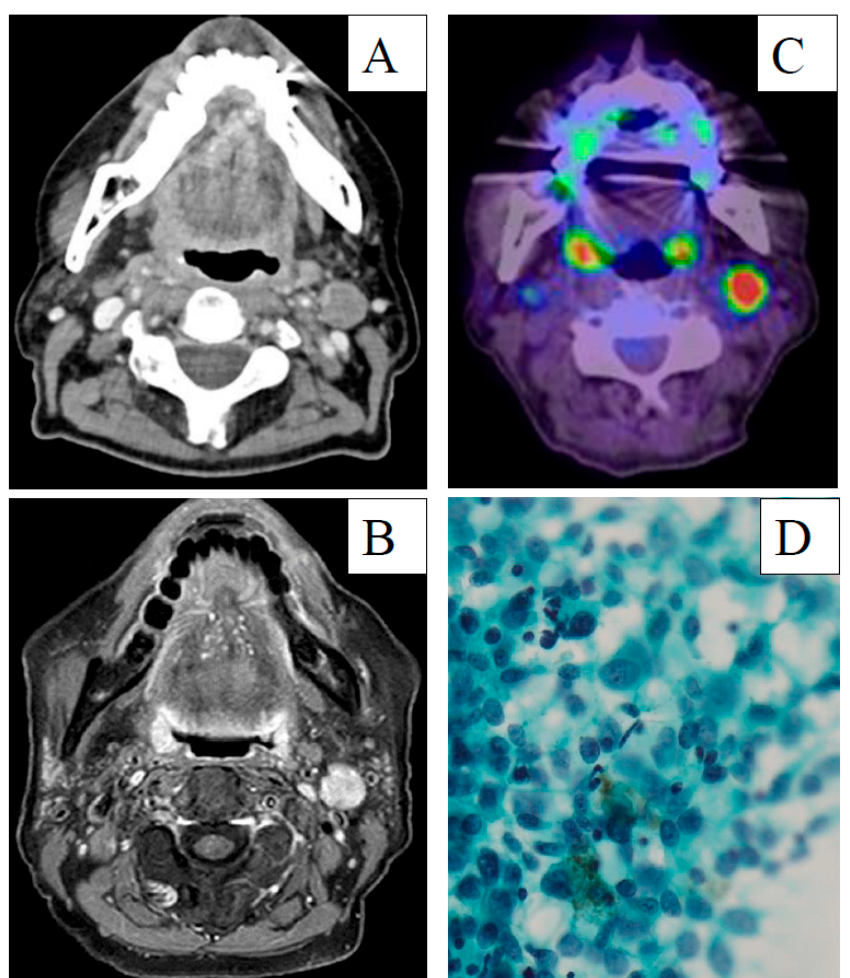
Figure 3. ( A ) Enhanced computed tomography image, ( B ) Magnetic resonance, ( C ) 18F-fluorodeoxyglucose positron emission tomography with computed tomography, imaged and ( D ) Papanicolaou staining of the metastatic lymph node. Scale bar = 100 µm .